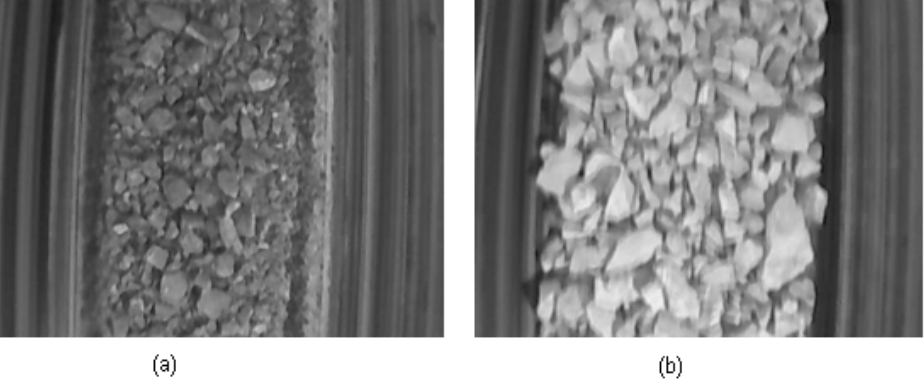
Figure 15. Sample belt images. ( a ) and ( b ) represent different image samples of the total of 215.